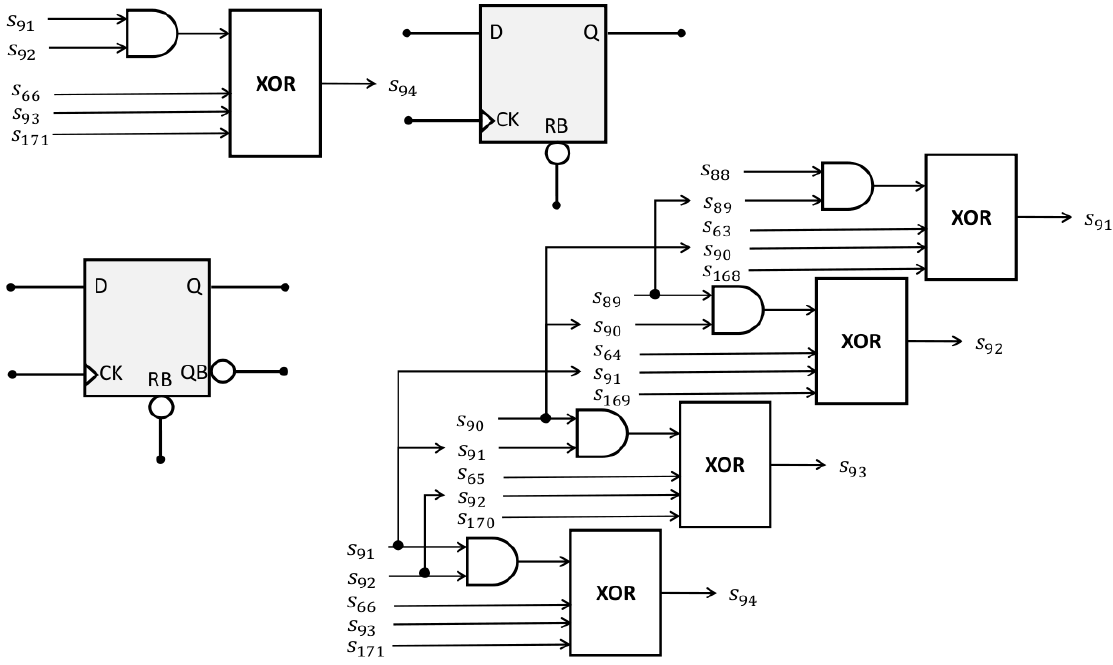
Figure 6. Effect of cell selection: multiple